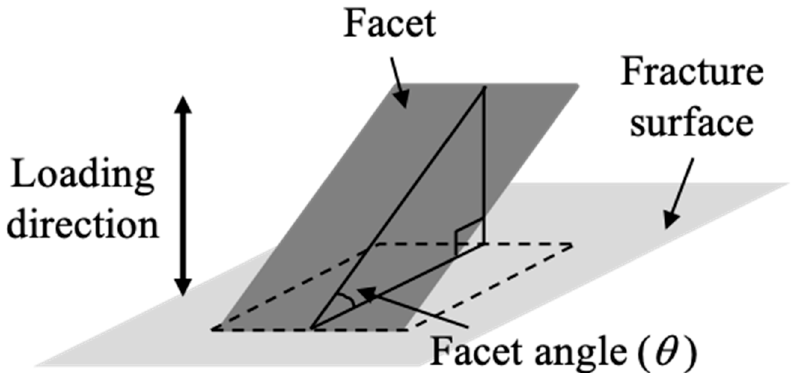
Figure 4. Schematic of the facet angle measurement.